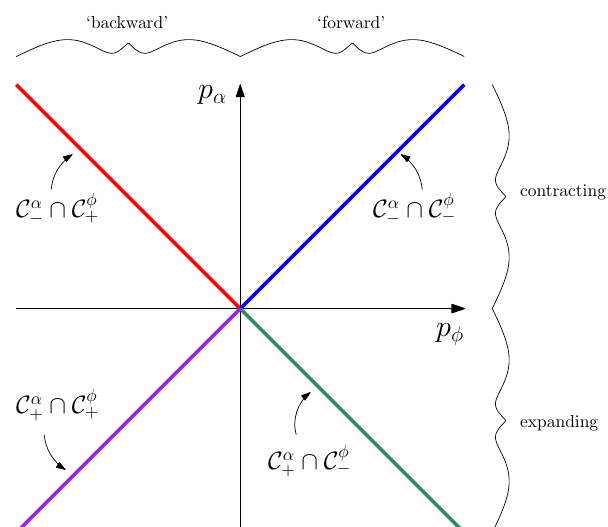
Figure 1. Schematic representation of the constraint surface C , defined by (1), as a ‘light cone’ in momentum space. Its four components have the following physical interpretation. Red: contracting universe, but φ runs ‘backward’. Blue: contracting universe and φ runs ‘forward’. Green: expanding universe and φ runs ‘forward’. Purple: expanding universe, but φ runs ‘backward’. At the intersection point (the origin) the dynamics is